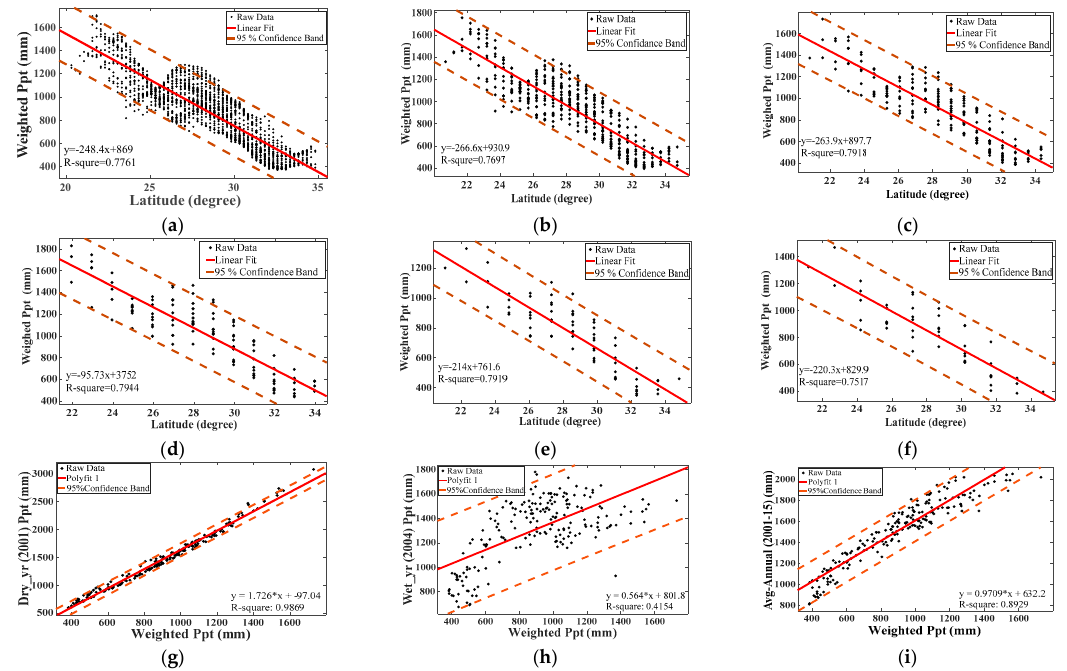
Figure 5. Scaled wise relationship between the weighted precipitation and ( a ) latitude at 0.25° resolution; ( b ) latitude at 0.50° resolution; ( c ) latitude at 0.75° resolution; ( d ) latitude at 1.0° resolution; ( e ) latitude at 1.25° resolution; ( f ) latitude at 1.50° resolution; ( g ) the dry year (2001) precipitation at 0.75° resolution; ( h ) the wet year (2006) precipitation at 0.75°; and ( i ) the average annual (2001–2015) precipitation at 0.75°, respectively.